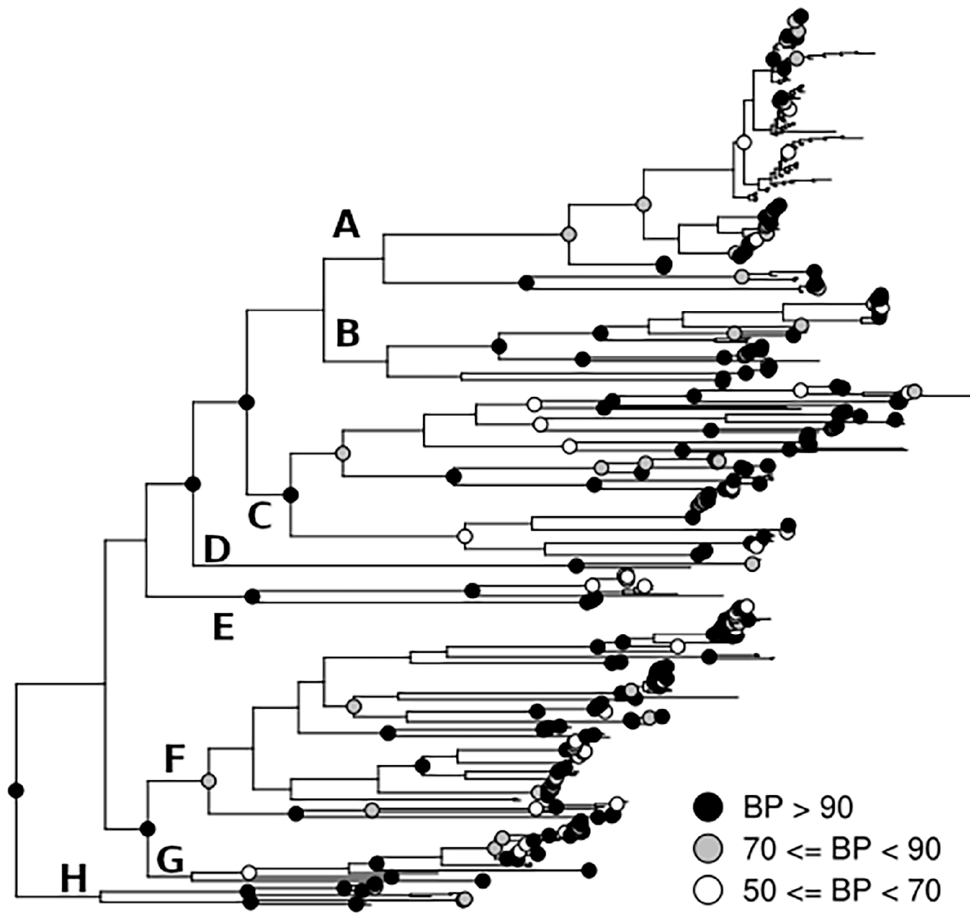
Figure 2. Results of phylogenetic analysis of all individuals. Letters on nodes indicate eight sub- clades; for details, see Figures 3–5 and supplementary materials (Figures S2–S4, Table S1). Circles represent branch support based on Bayesian posterior probability (PB).